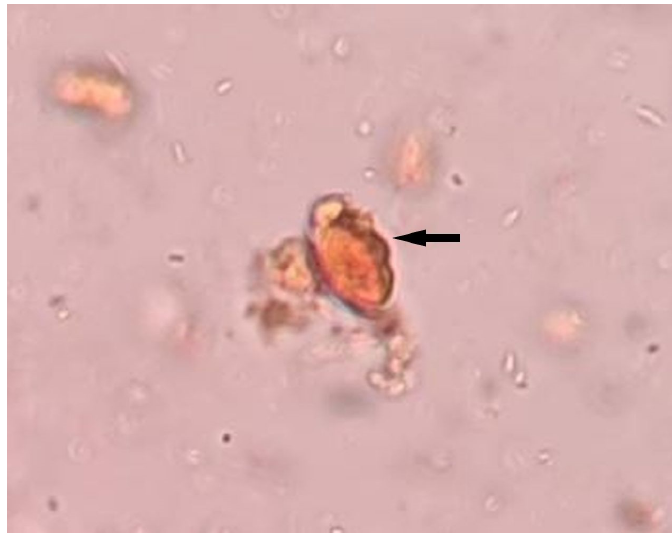
Figure 1. Stool for ova and cyst shows presence of T. Trichiura ’s egg (black arrow). Table 1. Complete blood counts with differentials before and after treatment. Pre-Treatment with Oral Parameters